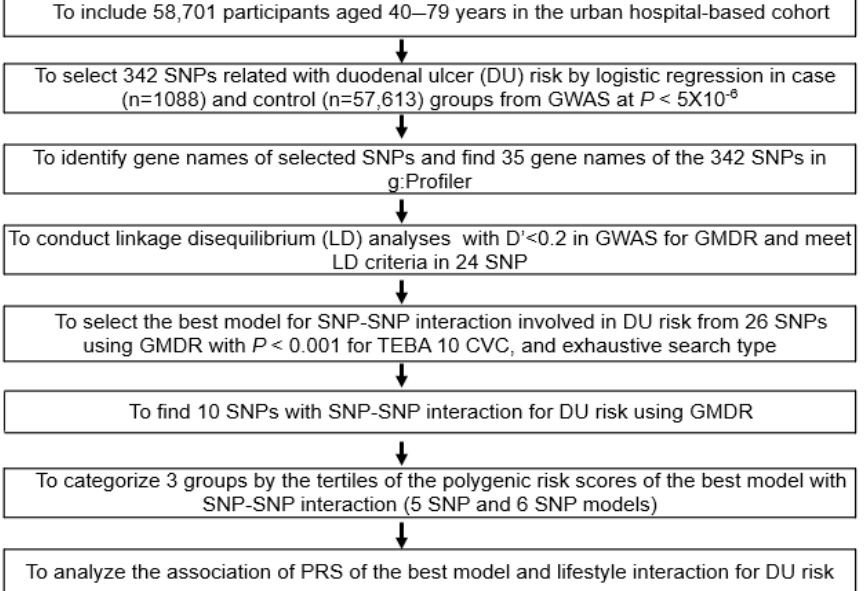
Figure 1. Flow chart to generate polygenic risk score (PRS) linked to duodenal ulcers by SNP-SNP interaction and its interaction with lifestyle factors. SNP: Single nucleotide polymorphisms.